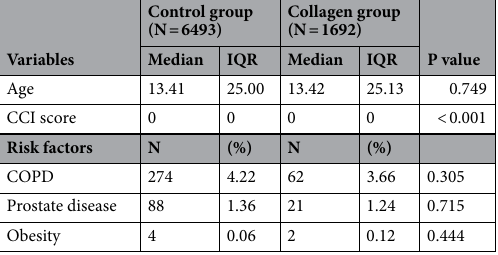
Table 1. Basic characteristics of the collagen diseases group and control group in Asian adult male